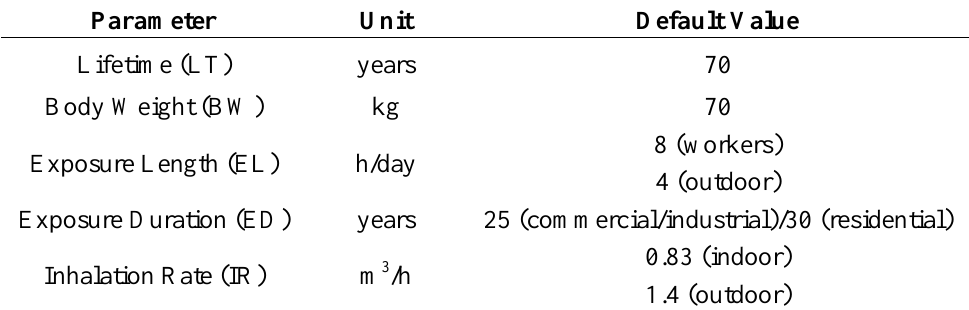
Table 3. Summary of USEPA standard default exposure factors [23,48].